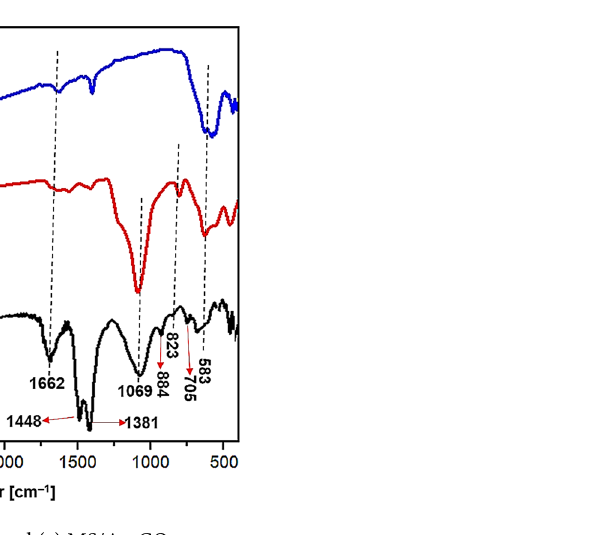
Figure 2. FT-IR of ( a ) Fe 3 O 4 , ( b ) MS and ( c ) MS/Ag 2 CO 3